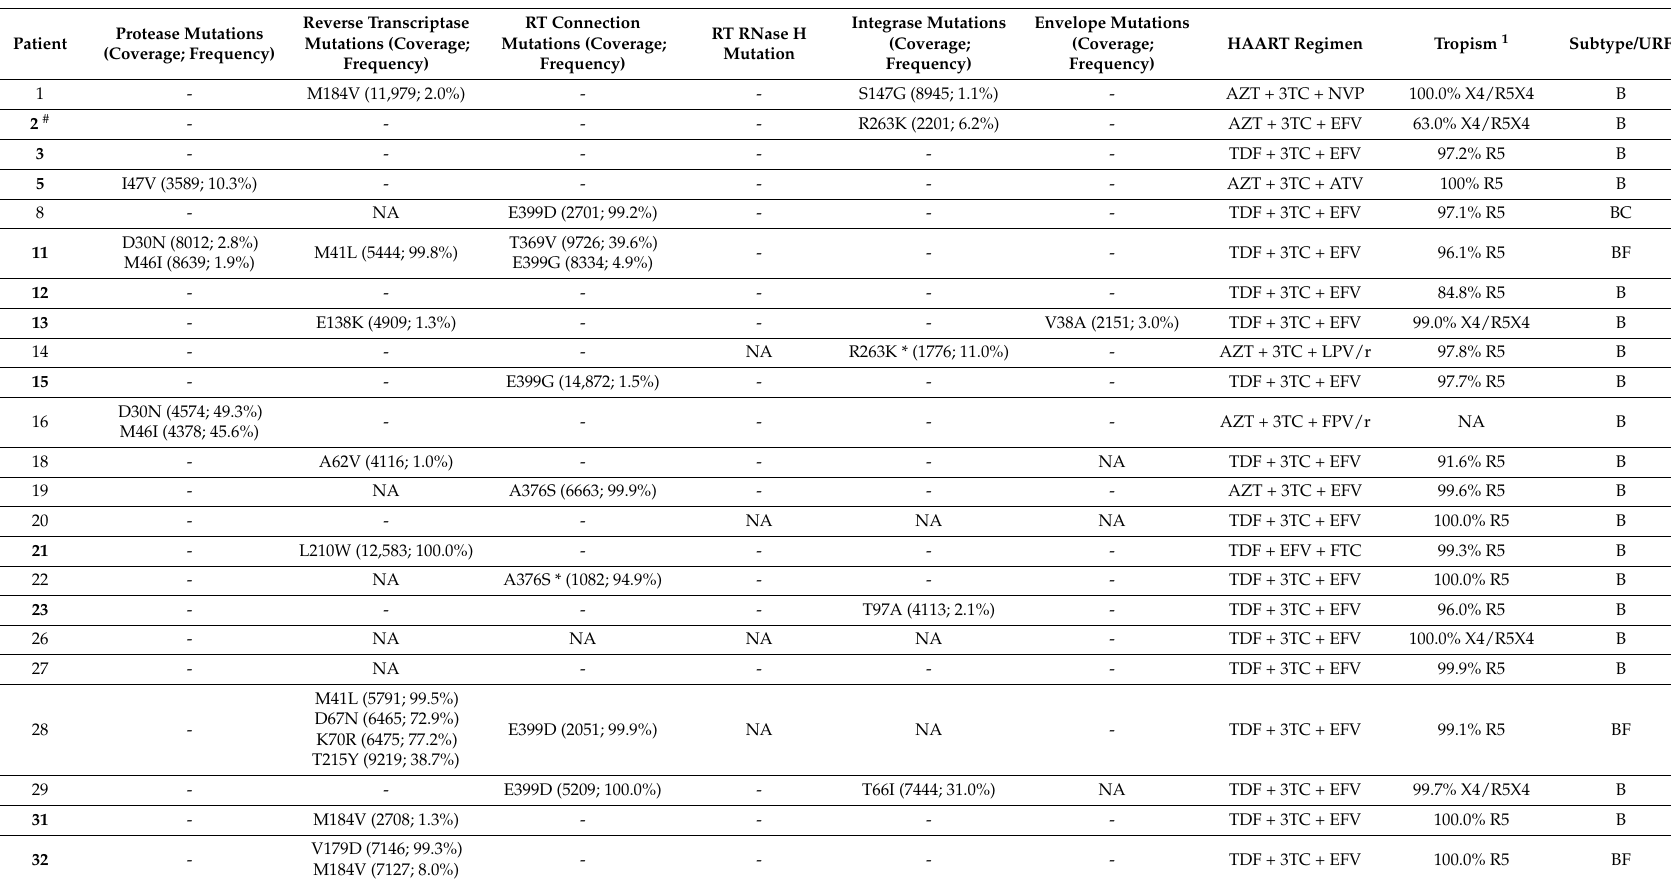
Table 3. Distribution of the antiretroviral resistance mutations and major envelope tropism found across the 23 HIV-1 genome sequences analyzed.